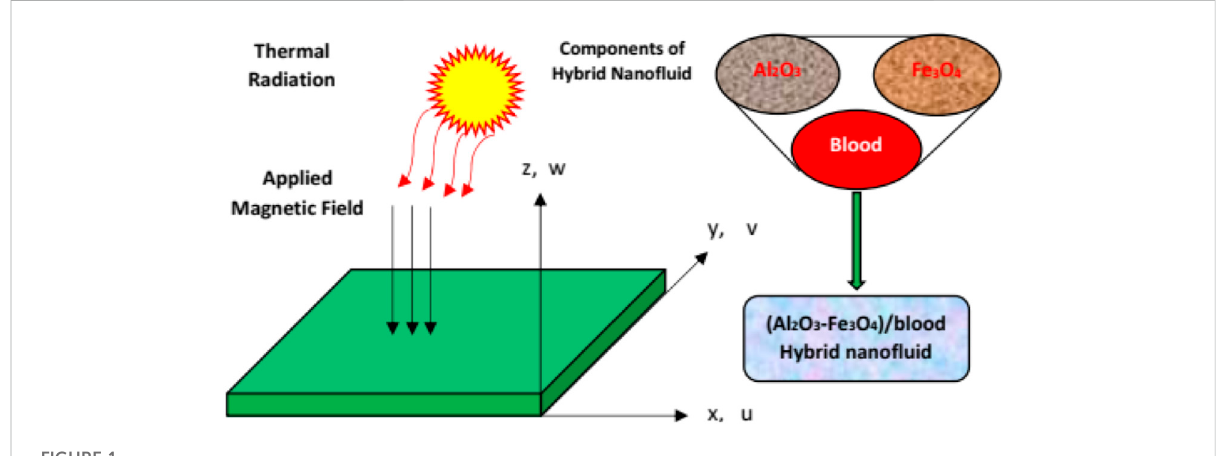
FIGURE 1 The Physical fl ow con fi guration of (Al 2 O 3 -Fe 3 O 4 )/blood and Al 2 O 3